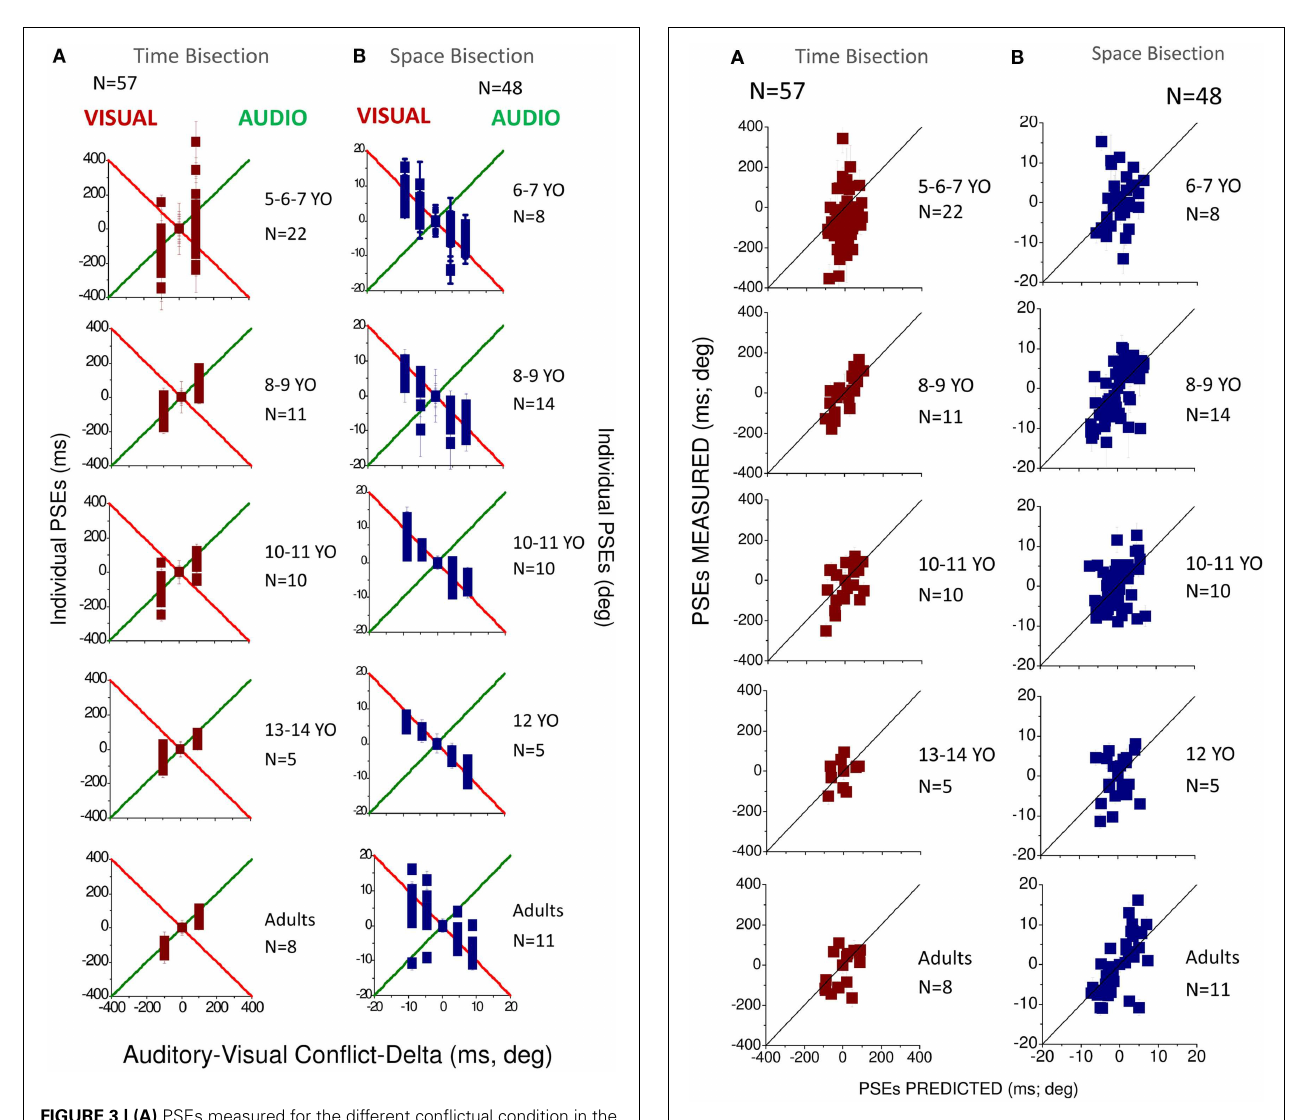
FIGURE 4 | (A) Measured against predicted PSEs for the different conflictual conditions in the temporal bisection task. (B) Measured against predicted PSEs for the different conflictual condition in the spatial bisection task. In both panels the black line represents the prediction of the Bayesian model and suggests optimal integration. Different ages are reported in different panels.The number of subjects who participated is indicated in each panel for each age and